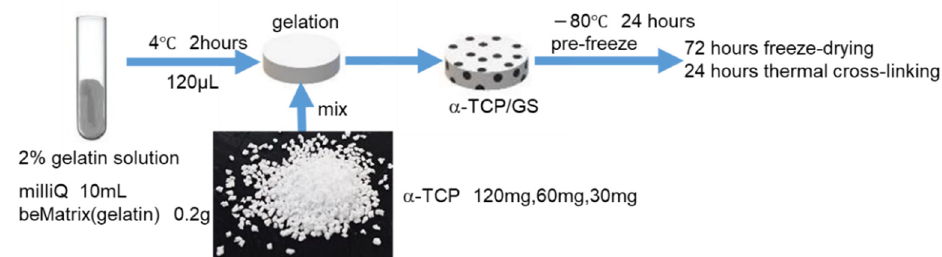
Figure 1. Fabrication method of α -TCP/GS.